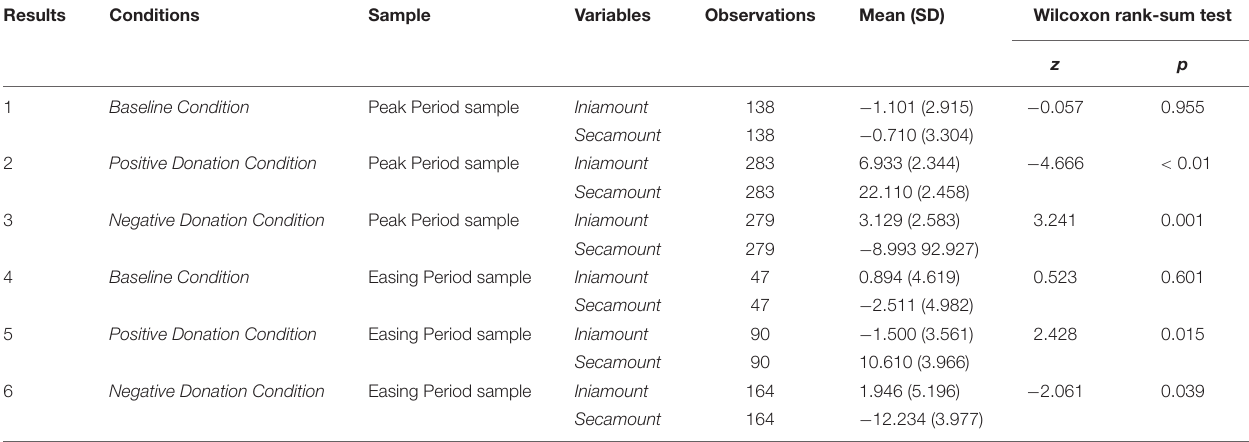
TABLE 2 | Results for the effects of social information on donation decisions.